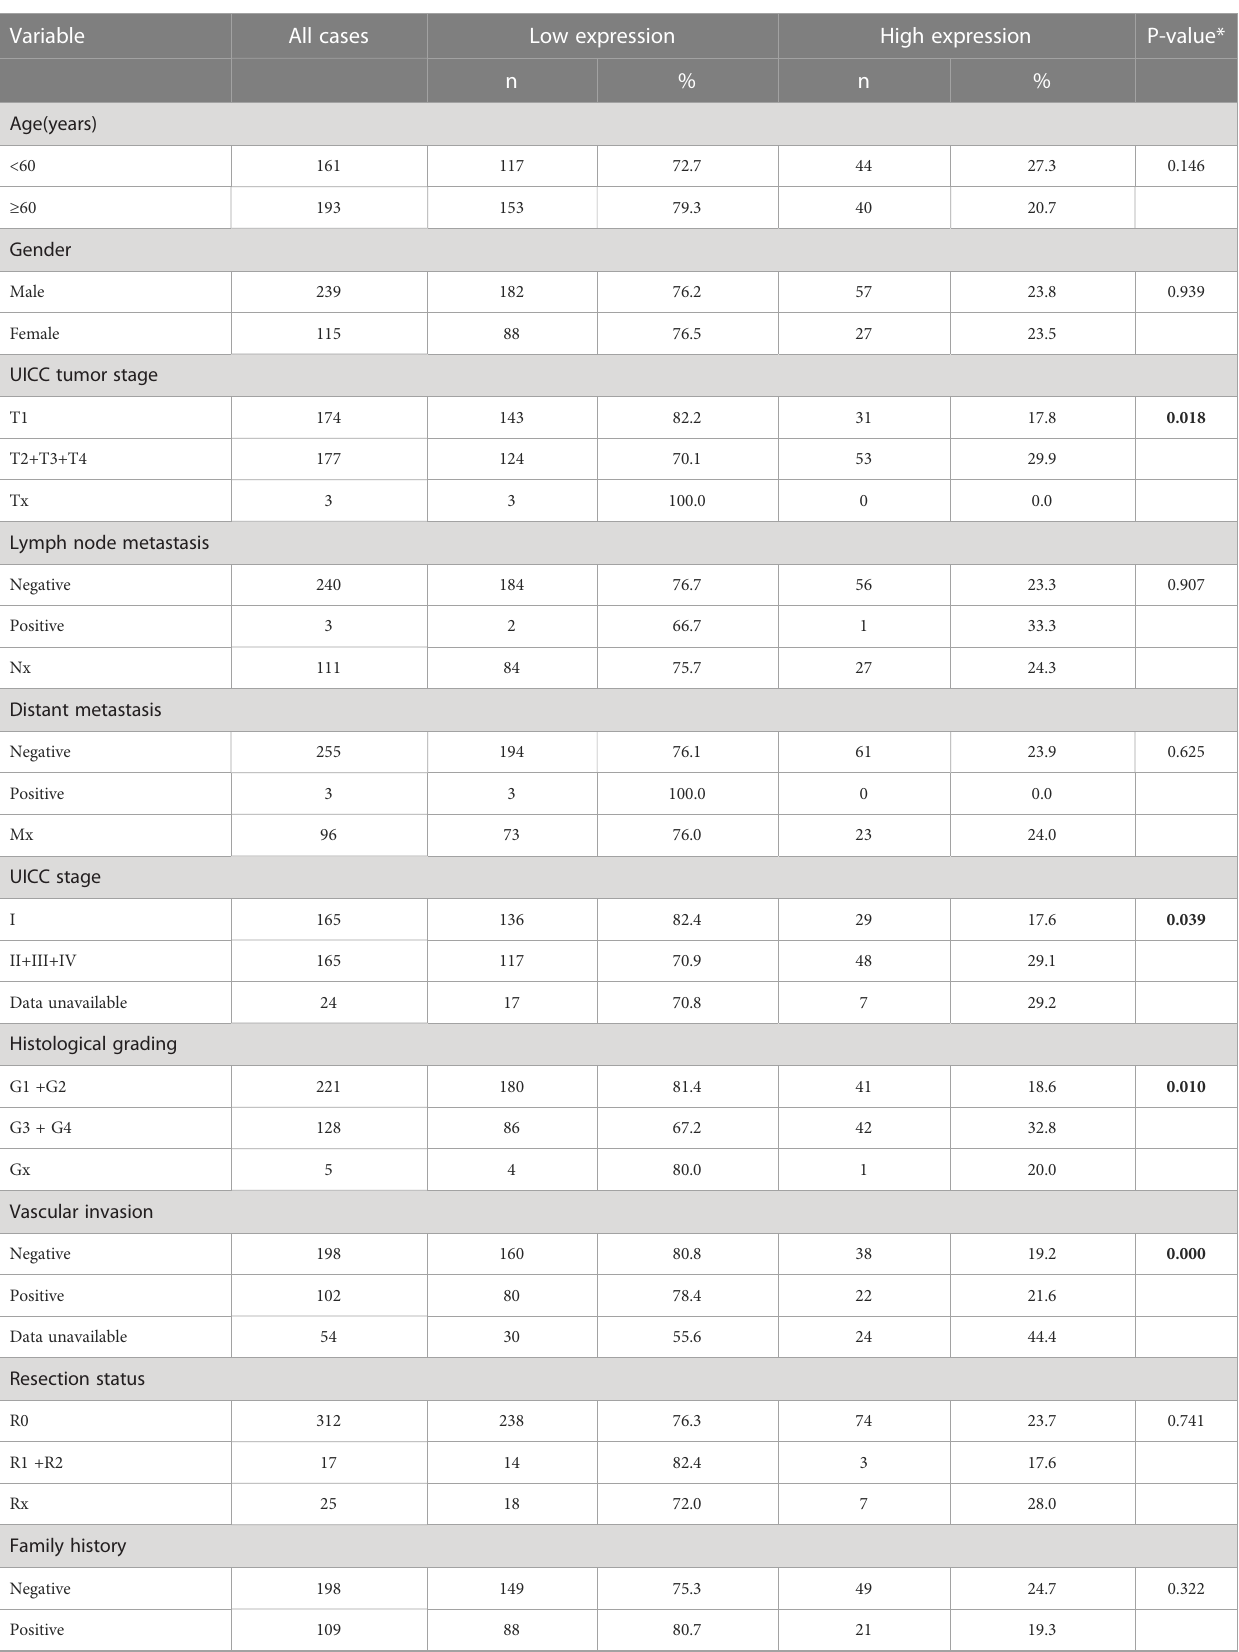
TABLE 1 Correlation between the clinicopathologic variables and FBXO43 expression in HCC